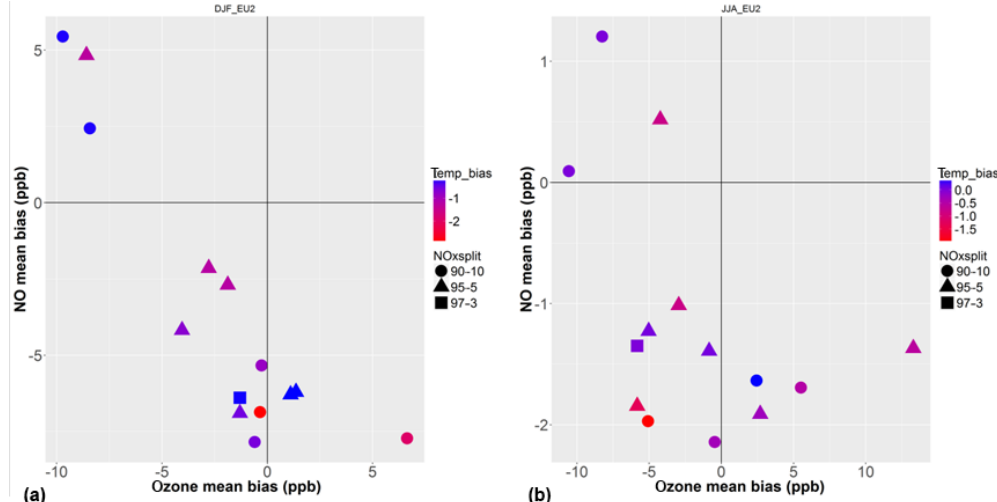
Figure 21. Ozone vs. NO modeled mean bias for the EU2 subregion, color-coded by temperature bias and symbols according to the NO x emission fraction of NO and NO 2 . Each point represents a model. (a) Winter months and (b) summer